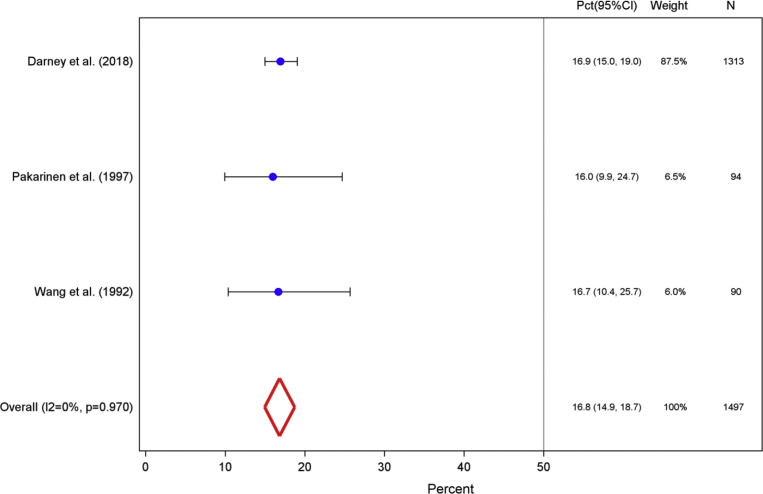
Days 272–365Weighted percentage of levonorgestrel intrauterine system users who experienced amenorrhea, excluding Modesto et al,28 for the fourth interval after insertion.CI confidence interval; Pct, percentage.Sergison and Maldonado. Amenorrhea associated with LNG-IUS use. Am J Obstet Gynecol 2019.